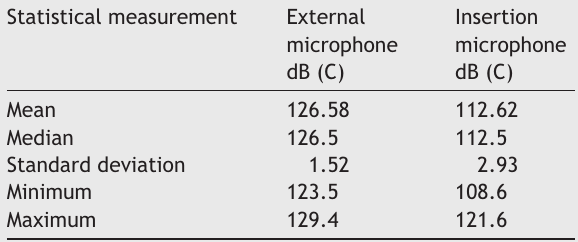
Lmax dB (C) measurement results obtained by the external and insertion